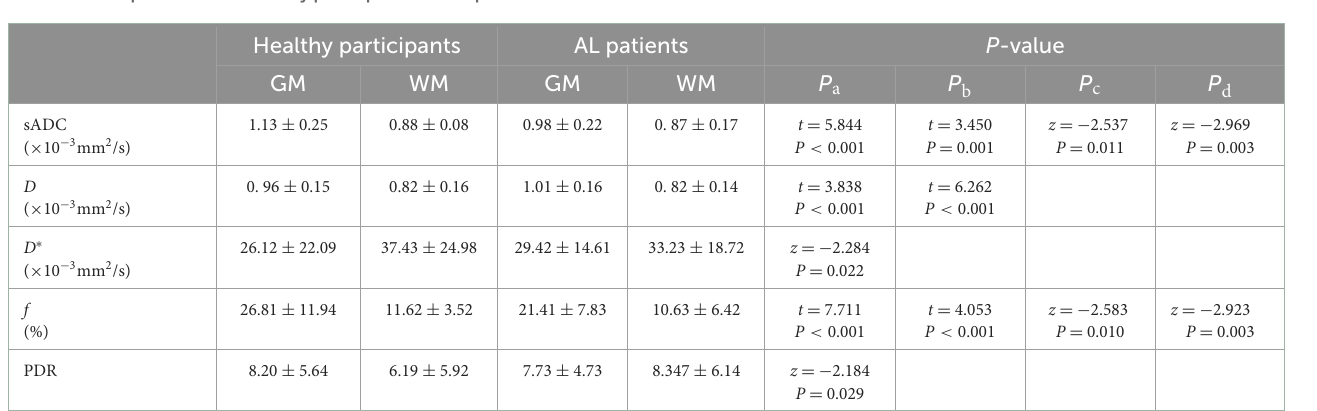
TABLE 1 IVIM parameters of healthy participants and AL patients. Healthy participants AL